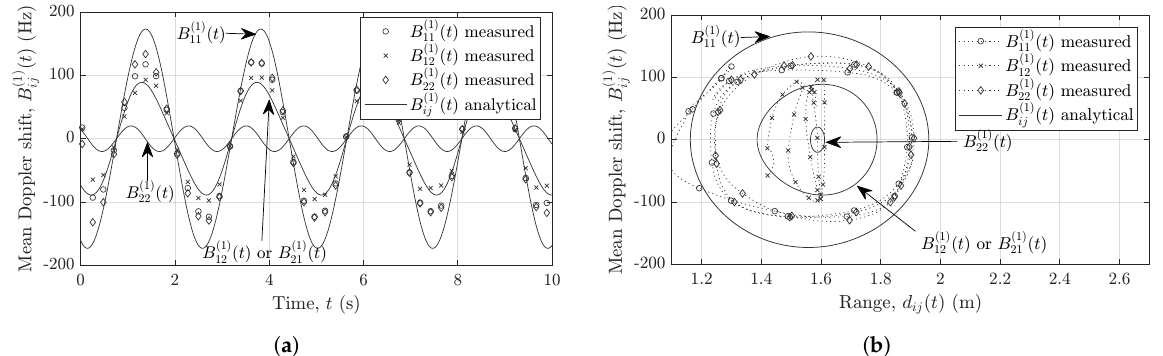
( 1 ) ( t ) vs. time and ( b ) the measured mean Doppler shift B ( 1 ) ij